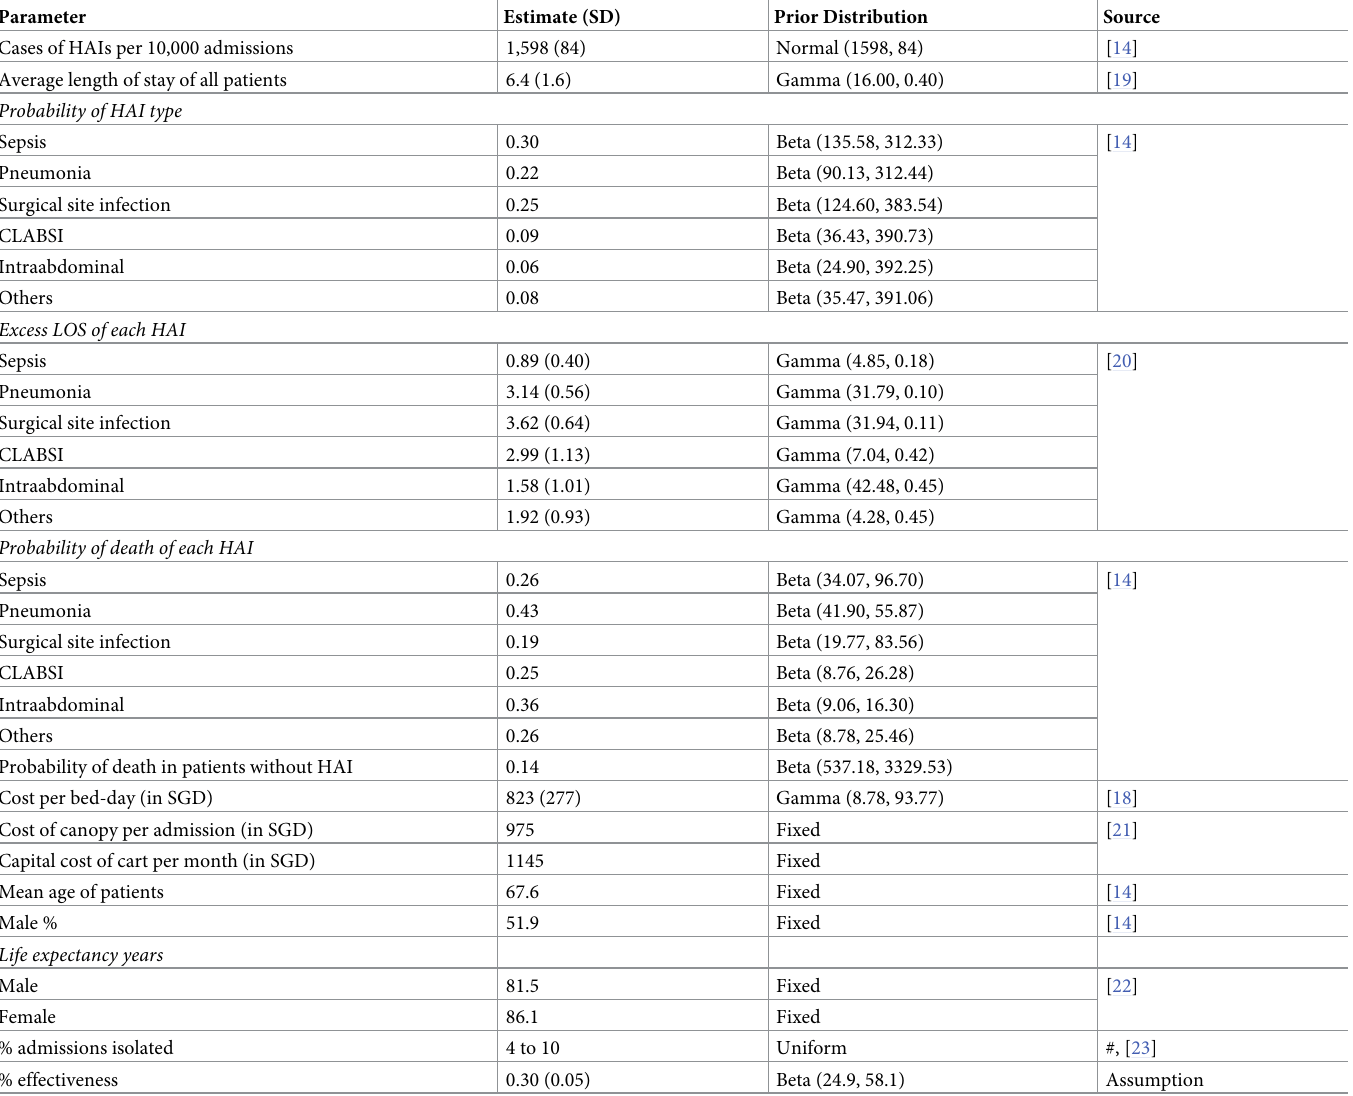
Table 2. Input parameters for the cost-effectiveness